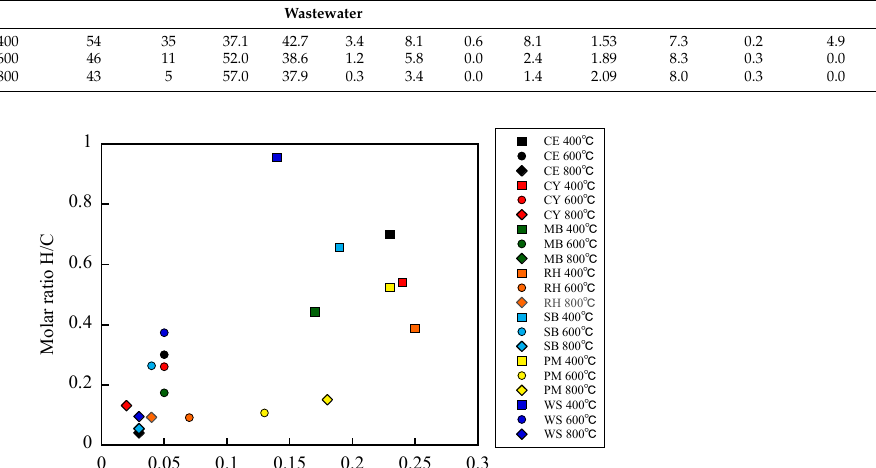
Figure 1. van Krevelin diagram of biochar samples (data taken from Table 1).